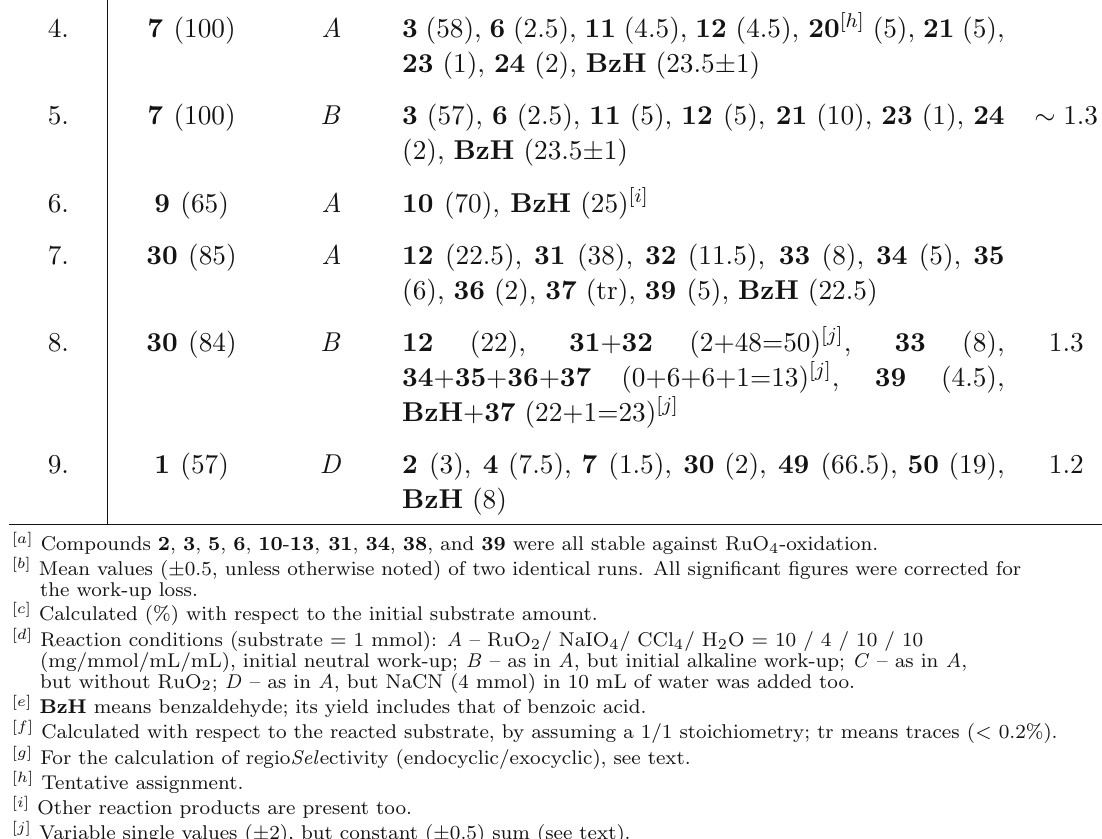
Table 1 Oxidation of piperazine derivatives with the RuO